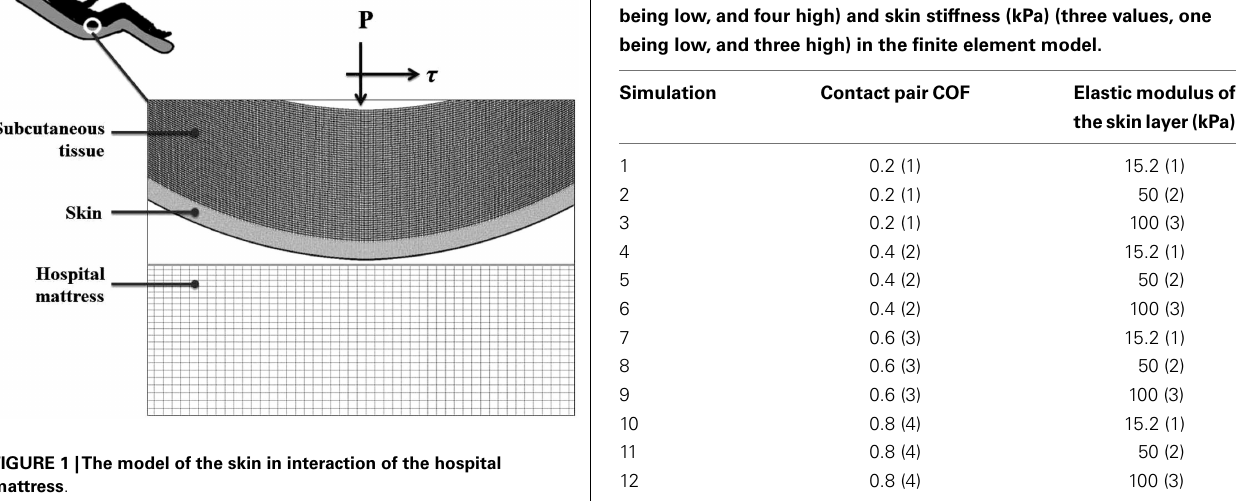
Table 2 |Taguchi orthogonal array consisting of twelve simulations to assess the influence of change in contact pair COF (four levels,